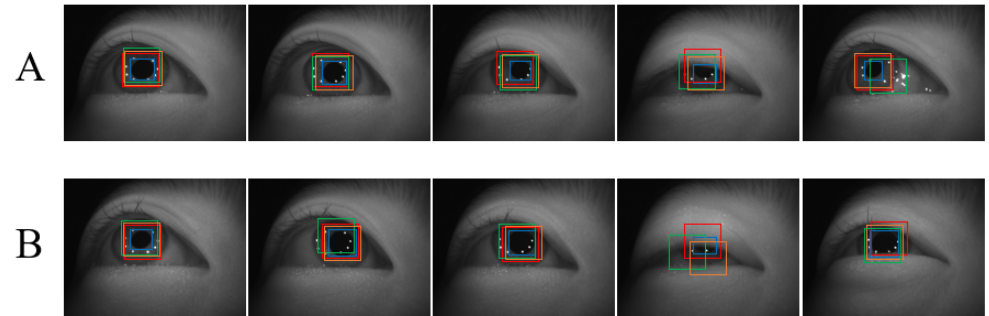
Figure 6. Results of pupil extraction. The blue, red, yellow, and green boxes represent the results of detection, MOSSE, KCF-gray, and KCF-hog, respectively. The upper figures are the results of pupil extraction in group A , when the eyeballs moved randomly with normal blinking. The lower figures are the results of pupil extraction in group B , when the eyeballs moved randomly with occasional squinting.